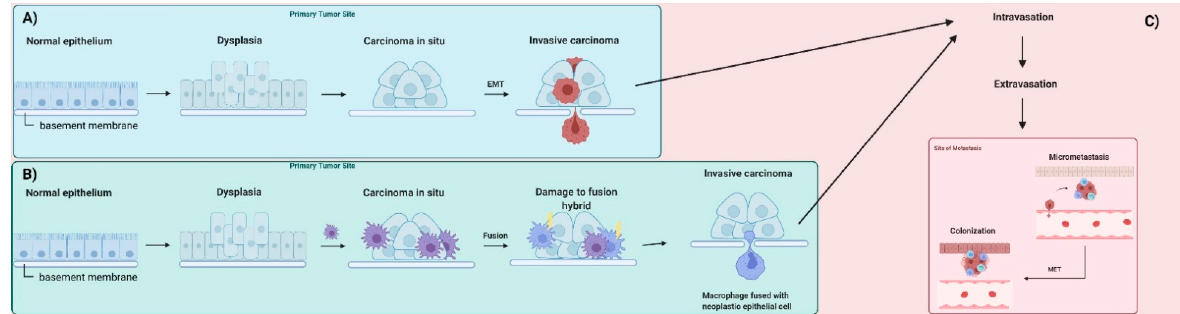
Figure 1. Overview of tumor metastasis. ( A ) Conventional model of metastasis. Normal epithelia are lined with a basement membrane that separates epithelia or endothelia from the connective tis- sues located beneath. Epithelial cells proliferate and become dysplastic. Accumulation of genetic and epigenetic changes leads to the formation of carcinoma in situ also lined with the basement membrane. During epithelial–mesenchymal transition (EMT), cells acquire abilities that allow them to move through the basement membrane. ( B ) The metastatic process according to the fusion hybrid hypothesis. Metastatic cancer cells are formed as a result of direct transformation or as a result of fusion of neoplastic epithelial cells and myeloid cells such as macrophages. ( C ) Metastatic cancer cells intravasate into small blood (shown here) and lymph vessels, where they travel with circula- tion to distant sites. At secondary sites, carcinoma cells extravasate, form micrometastases, and in the process of mesenchymal–epithelial transition (MET) colonize the foreign tissue (macrometasta- sis). Based on [33]. 5. Cancer Stem Cells in Metastasis Despite the fact that the presence of cancer stem cells (CSCs) is still widely debated, the CSC hypothesis is of significant clinical significance, because it has the potential to explain tumor resistance to chemotherapy, cancer progression, and recurrence in cancer patients [72,73]. CSCs or tumor-initiating cells (TICs) represent a sub-population of cells that exhibit self-renewal ability and the capacity to differentiate. The undifferentiated state is maintained through the transcriptional regulation of four major transcription fac- tors: SOX2, OCT4, and NANOG [74–77]. Moreover, compared with normal stem cells, CSCs are highly clonogenic. When a self-renewing stem cell divides, it can choose one of two important cell division fates: symmetric division, which results in the formation of two daughter stem cells; or asymmetric division, which results in the formation of a stem cell and a differentiated daughter cell. Mutations in tumor suppressors that are involved in the restriction of asymmetric stem cell division equip cancer stem cells with mecha- nisms to hyperproliferate [78–80]. Moreover, it was found that cancer cells can undergo the EMT following stimuli from the cells in the tumor environment, which subsequently leads to the formation of cells with features similar to CSCs [81]. Moreover, the conversion of non-stem cancer cells to CSCs, such as in the case of trastuzumab resistance resulting in CSC proliferation, occurs predominantly as a result of IL-6 release by CSCs in the tumor microenvironment. IL-6 is also capable of inducing the expression of other cytokines that are beneficial to CSCs development [82–85]. Furthermore, through juxtacrine signaling or contact-dependent signaling, TAMs may aid in the formation of a CSC niche [86]. Re- search indicates that CAFs produce 100 times more interleukin-6 (IL-6) than nonmalignant tissue associated fibroblasts, which can actually enhance the invasive characteristics of the cells [87]. The acquisition of mesenchymal features may help cells to disseminate from primary tumor mass. Likewise, cells may undergo the mesenchymal–epithelial transition (MET) to the epithelial state at the site of metastasis [88–90]. CSCs emergence is strongly associated with the development of resistance mecha- nisms to anticancer agents. Chemoresistance of CSCs and their continuous persistence following treatment with anticancer drugs is associated with a high risk of metastasis and the lower survival rates of patients. There are numerous factors that influence the inci- dence of CSCs resistance. These include interactions of CSCs with microenvironment